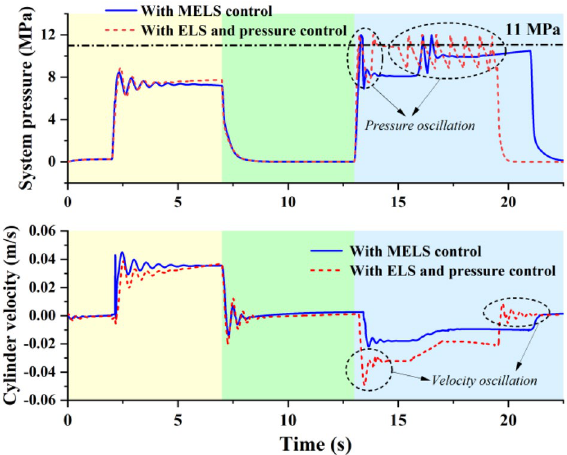
Figure 20 System pressure and cylinder velocity under variable external